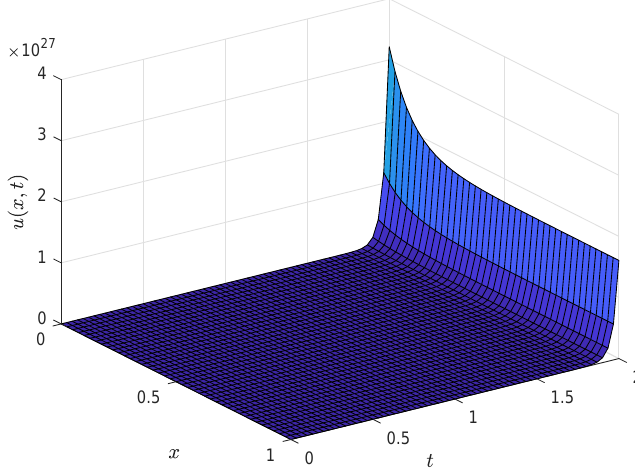
Figure 1. Open-loop response from the solution of the R-A-D PDE.